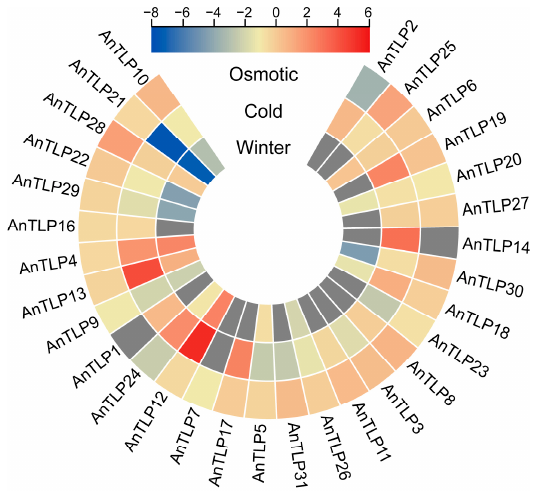
Figure 8. Expression pattern analysis of AnTLP genes based on transcriptome data.